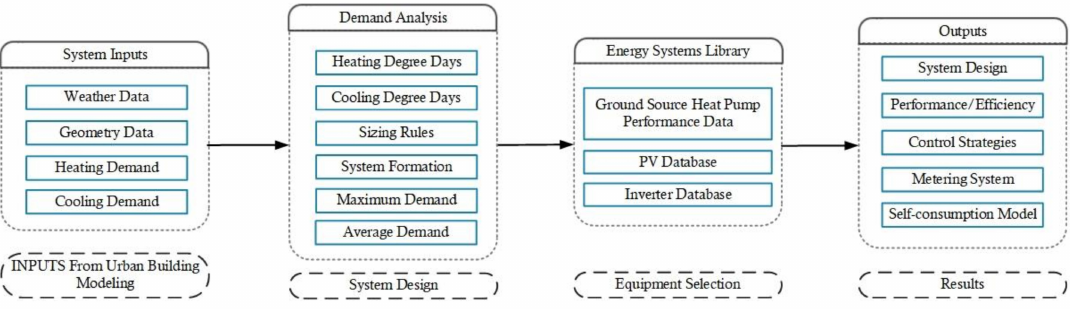
Figure 3. Energy System Model